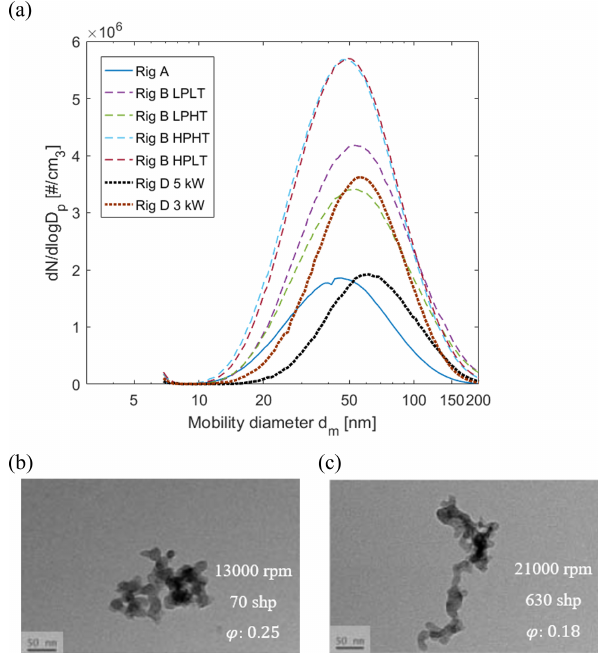
Figure 8. (a) Typical particle size distributions measured using the SMPS for the multiple sources and operating conditions: Rig A (kerosene-fuelled, HPO condition), Rig B (kerosene-fuelled, four operating conditions), and Rig D (diesel-fuelled, two load condi- tions); (b, c) typical TEM images of soot produced by a turboshaft engine (speed: 13000 (b) and 21000rpm (c) ; shaft horse power: 70 (b) and 630shp (c) ; and the estimated global equivalence ratio of 0.25 (b) and 0.18 (c) , respectively) at a magnification of 45000 × (Saffaripour et al.,